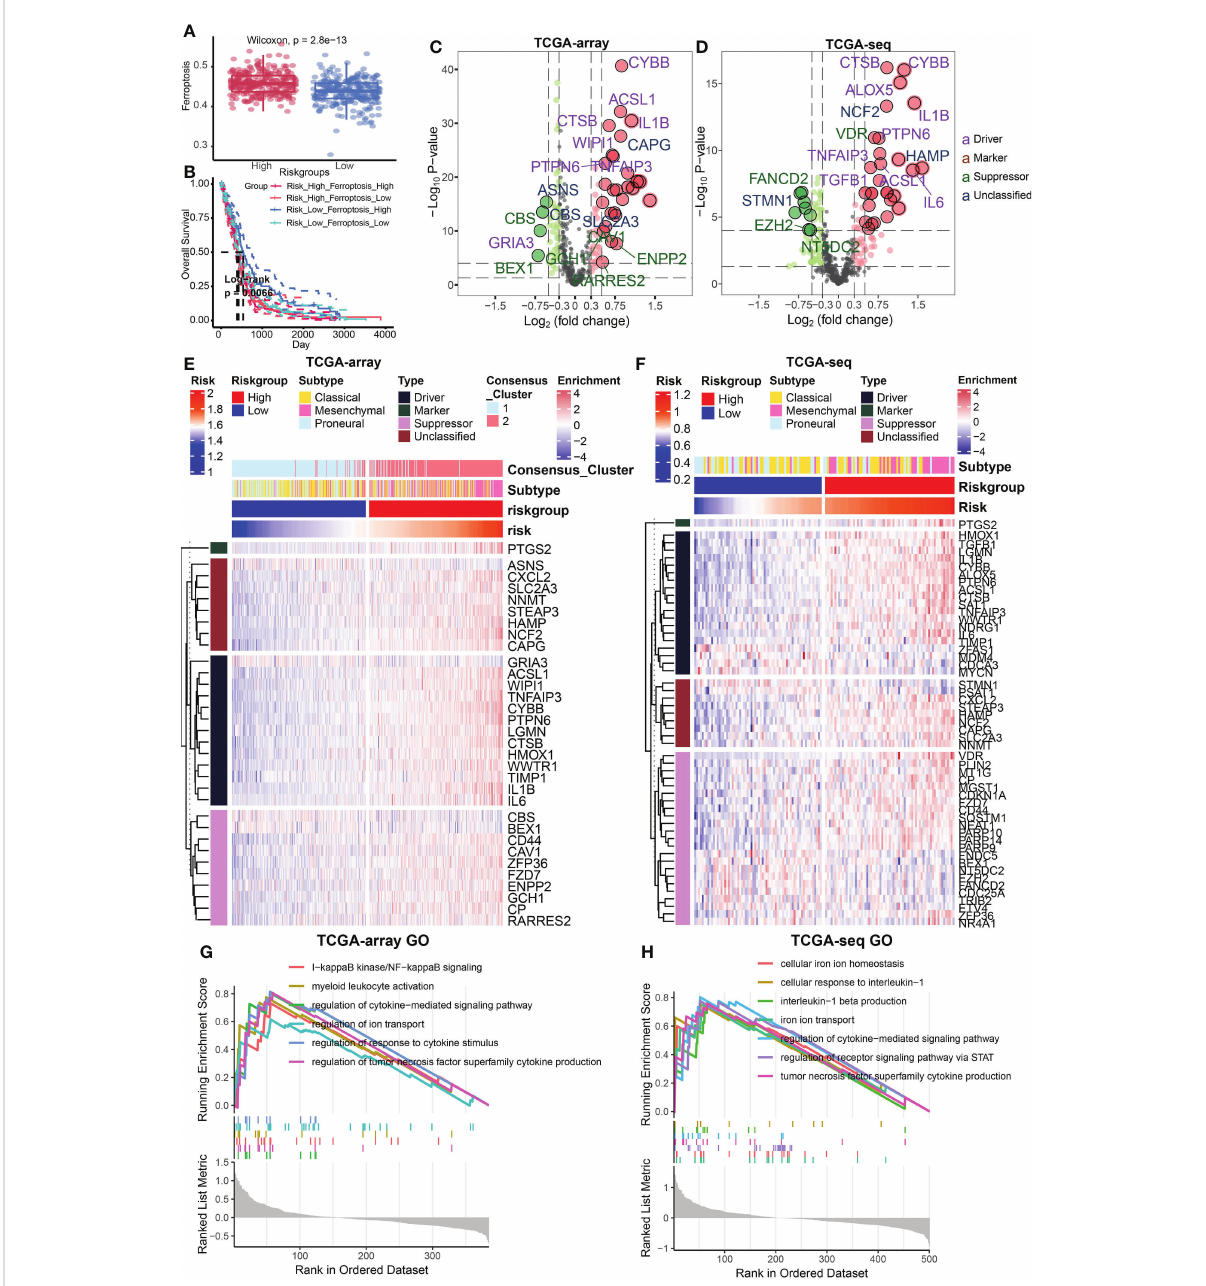
FIGURE 4 Relationship between risk signature and different cell death modes. (A) Ferroptosis regulators/markers were highly enriched in high-risk group based on the TCGA Array dataset. (B) Survival analysis revealed that the group with low-risk and high levels of ferroptosis possessed the best prognosis. (C, D) The volcano plots showed differentially expressed FRGs in the TCGA Array dataset (C) and TCGA Seq dataset (D) . (E, F) The heatmap displayed differentially expressed FRGs in the TCGA Array dataset (E) and TCGA Seq dataset (F) . (G, H) ssGSEA results of GO terms in TCGA Array dataset (G) and TCGA Seq dataset (H) . P < 0.05, statistically signi fi